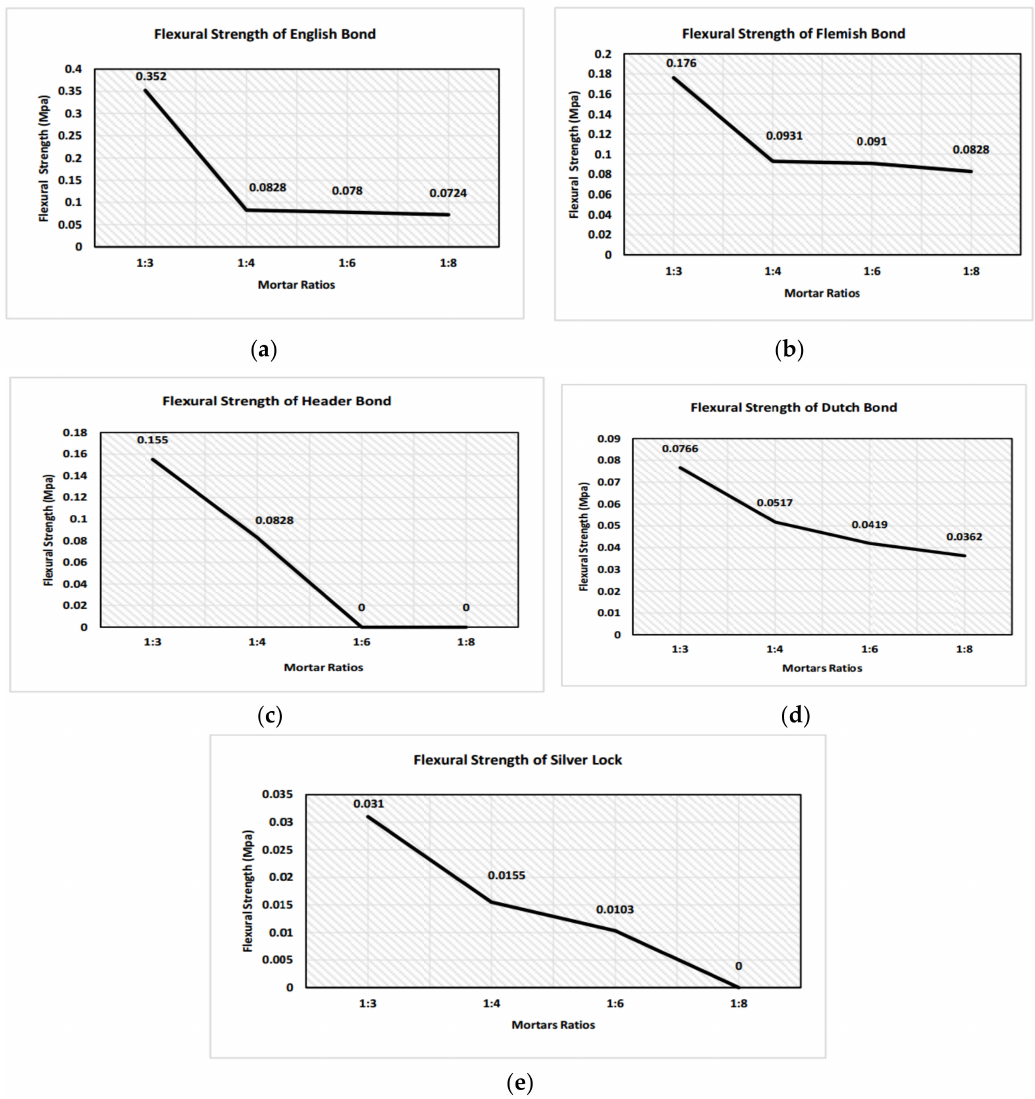
Figure 8. Flexural strength for ( a ) English bond; ( b ) Flemish bond; ( c ) header bond; ( d ) Dutch bond; and ( e ) silver-lock bond.